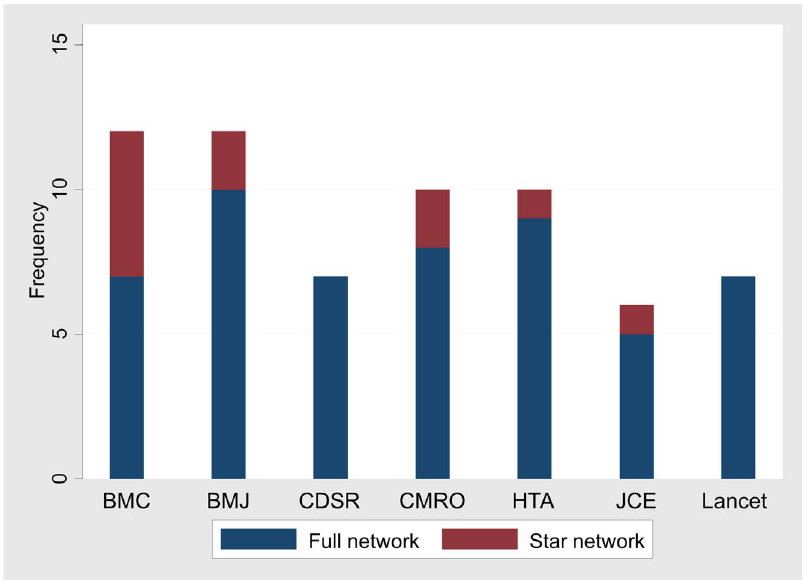
Figure 3. Number of meta-analysis articles with full and star networks published by journal. BMC: BioMed Central BMJ: British Medical Journal CDSR: Cochrane Database of Systematic Reviews CMRO: Current Medical Research & Opinion HTA: Health Technology Assessment JCE: Journal of Clinical Epidemiology.